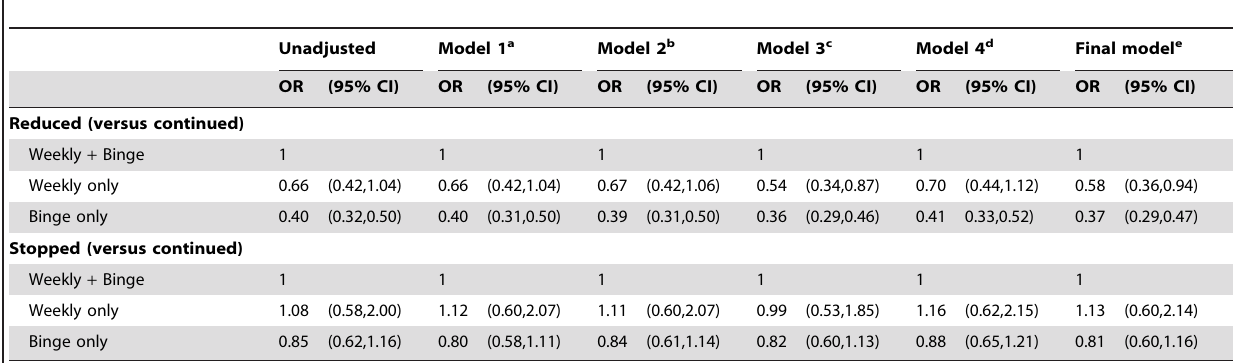
Table 3. The association of risky drinking patterns prior to pregnancy with changes in these patterns during